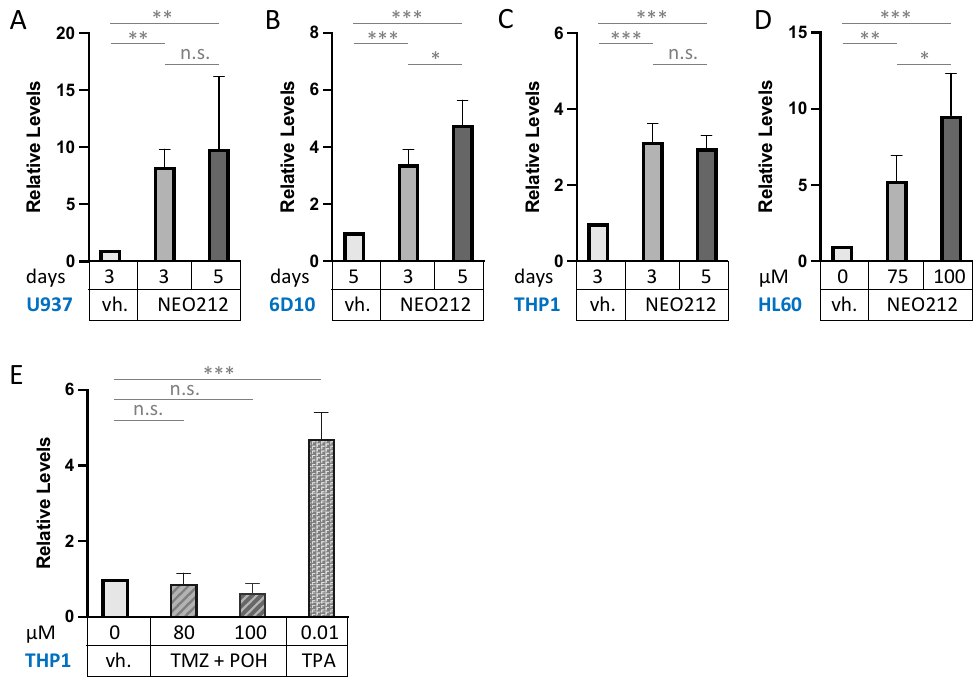
Figure 6. NEO212 increases CD11b mRNA levels. Drug-treated AML cell lines were harvested, and CD11b transcript levels were quantified by RT-qPCR. Control cells received vehicle (vh.) only (DMSO). ( A ) U937 cells were treated with 10 µM NEO212 for the indicated times. ( B ) 6D10 cells were treated with 10 µM NEO212. ( C ) THP1 cells were treated with 50 µM NEO212. ( D ) HL60 cells were treated with 10 µM NEO212. ( E ) THP1 cells were treated for 4 days with TMZ in combination with equimolar concentrations of POH. As a positive control, they were also treated with 10 nM TPA for 2 days. Asterisks: * = p < 0.05, ** = p < 0.01, *** = p < 0.001; n.s. = not significant.